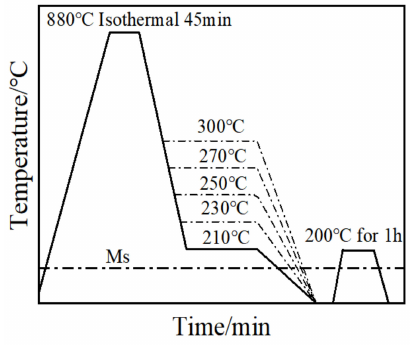
Figure 1. The figure of the heat treatment